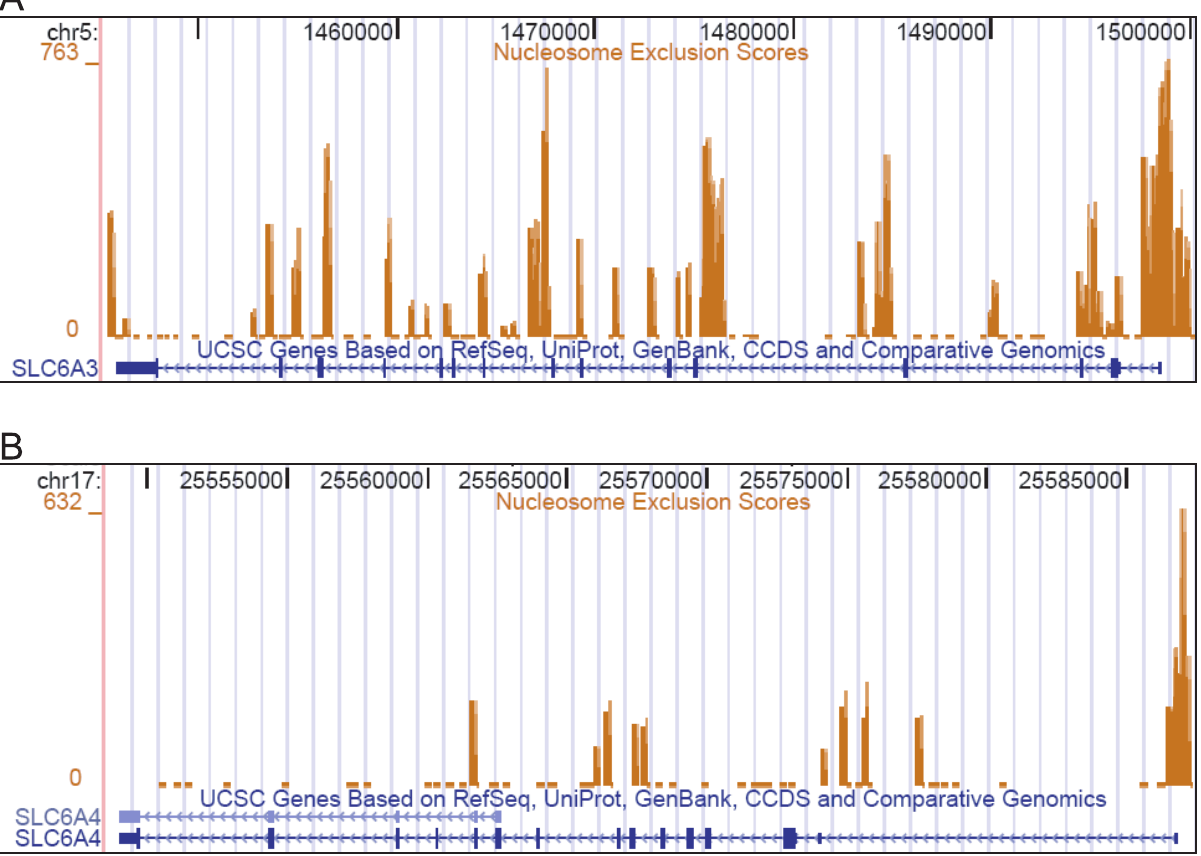
Figure 7. Nucleosome exclusion regions. Nucleosome-exclusion regions (NXRegions) are shown for the SLC6A3 (top panel) and the SLC6A4 (lower panel) genes. The figure was prepared by uploading NXScore results as a Custom Track on the UCSC Genome Browser interface where the snapshots showing the Known Genes track and Custom Track option were taken for the cognate gene’s loci. NXScore peaks in the SLC6A4 are largely confined to the TSS vicinity (as it is seen in most of the human genes) and the height of the TSS-overlapping peaks is dominant. Distinctly different pattern of the nucleosomes is predicted for the chromosomal region corresponding to the SLC6A3 : here multiple NXScore peaks are densely mapped to the different regions of the gene body and to the flanks. Notice that the height of the TSS-proximal NXScore peak is comparable with the other intragenic peaks.